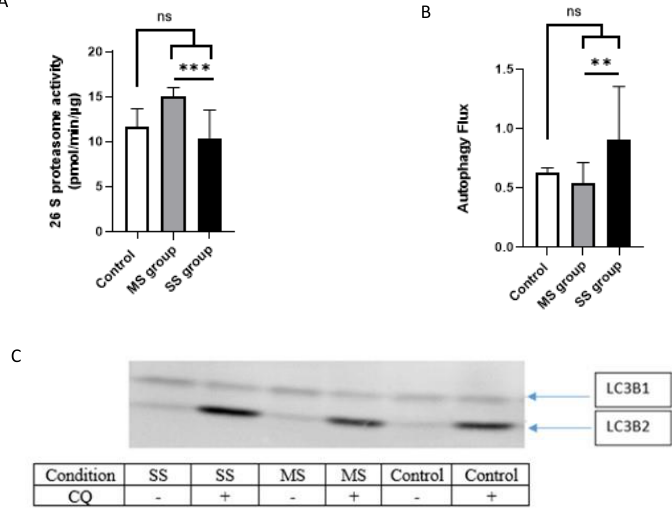
Figure 7. Autophagy and proteasome activity in human primary myotubes treated with HNC-patient tumor-conditioned media. ( A ): Proteasome activity human-differentiated myotubes incubated for 48 h with a mix of sera from either control patients (control), HNC patients with severe sarcopenia (SS group), or HNC patients with mild sarcopenia (MS). ( B ): Autophagy flux in differentiated myotubes incubated with mix of sera from control or cancer patients (MS and SS groups). The uncropped blots and molecular weight markers are shown in Supplementary Figure S5. ( C ) Illustration of a blot used in this study for the experiment shown in B. For experiments made with mixed sera from HNC patients, n = 2 replicates. ** p < 0.01, ***: p < 0.001.